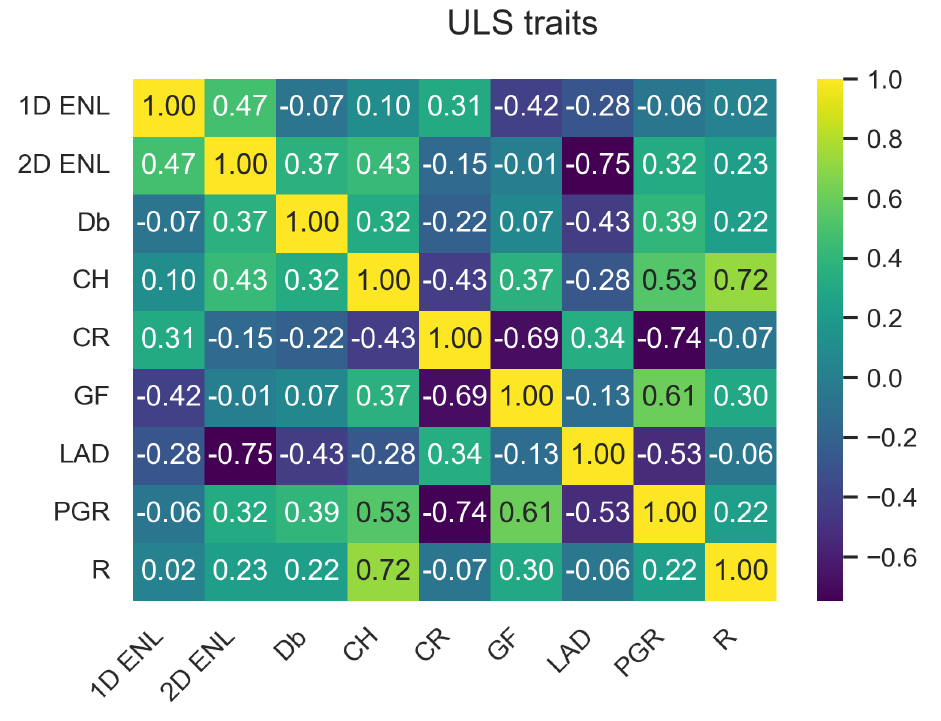
Figure A41. ULS correlation matrix at 5m grid size.